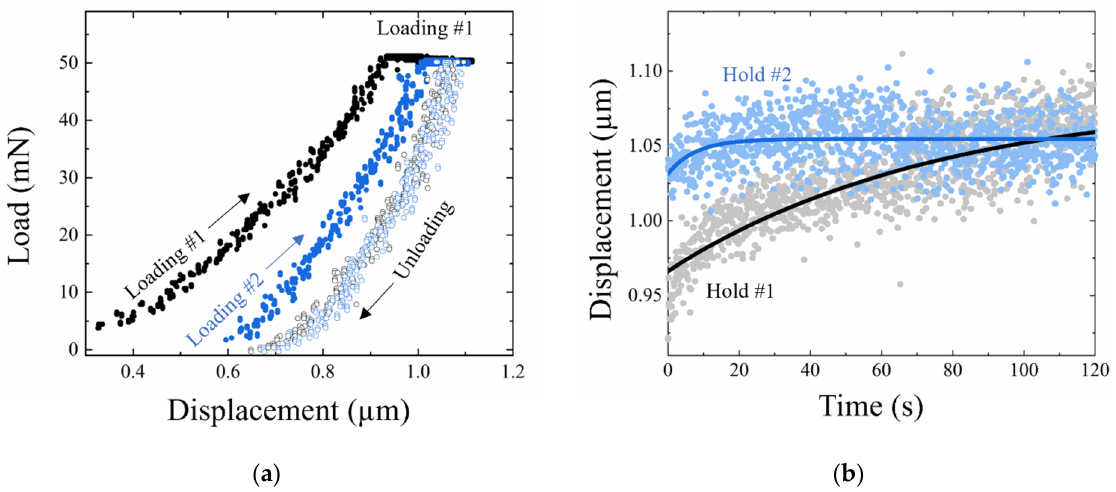
Figure 1. ( a ) Load–displacement curves from sequential compression of 30C-7× WF at the same position (first—Black; second—Blue). Each cycle consists of a loading segment (solid circle), a 120 s hold segment at maximum load (solid circle), and an unloading segment (empty circle). ( b ) Creep during the hold segment, showing the exponential decay to the point creep plateaus. The data (solid circles) have been fitted with an exponential decay function